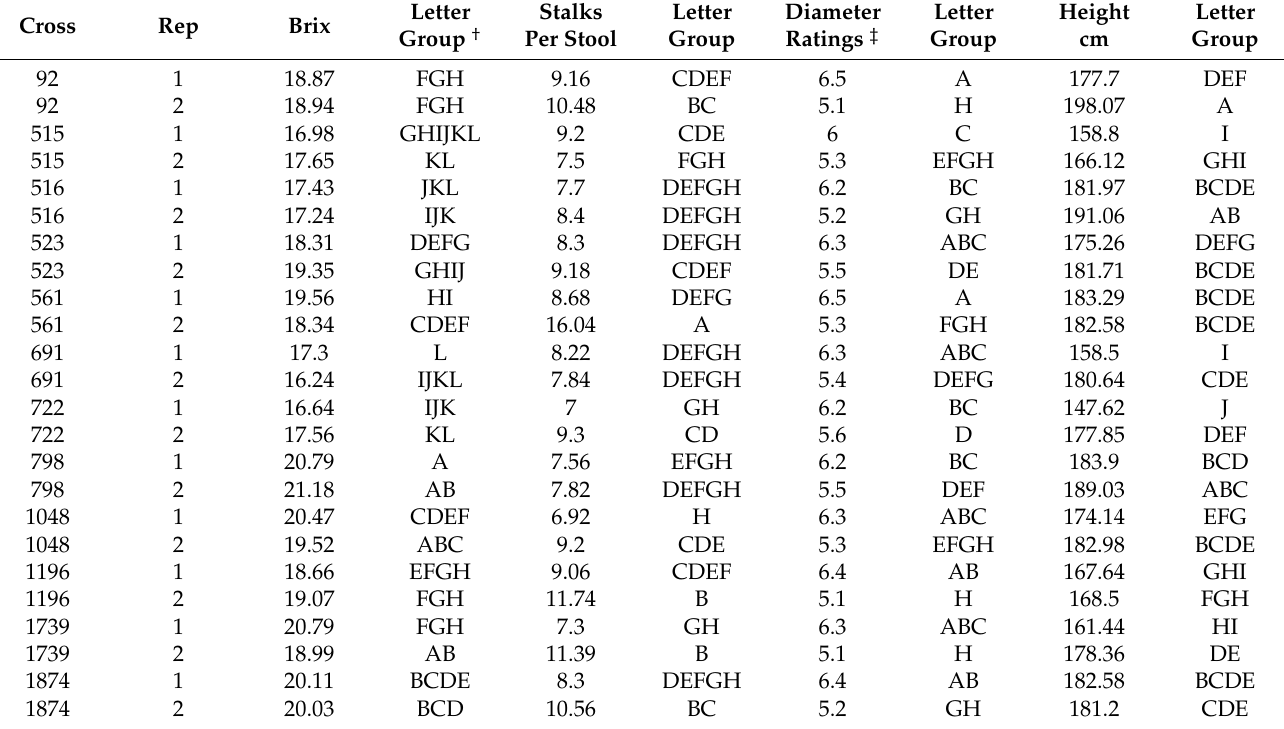
Table 4. Means and significance letters ( p = 0.05) of Brix, stalks per stool, Diameter ratings, and Height